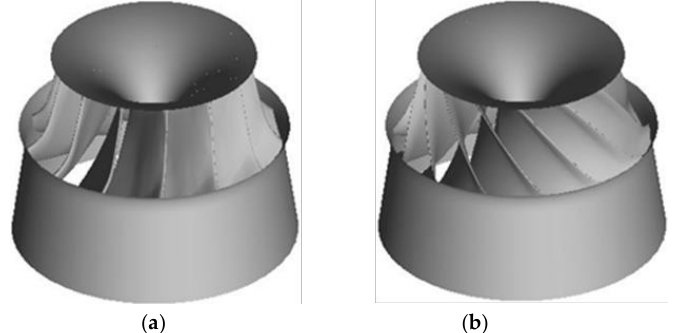
Figure 10. Geometry of the runners. ( a ) Initial runner; ( b ) Preferred runner. Energies 2019 , 12 , x FOR PEER REVIEW